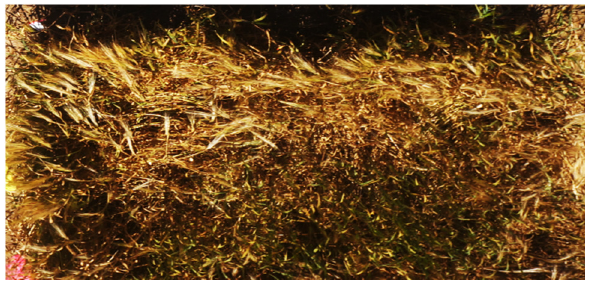
Figure 9. New grown plants (green) after high lodging severity and early development stage of occurrence.